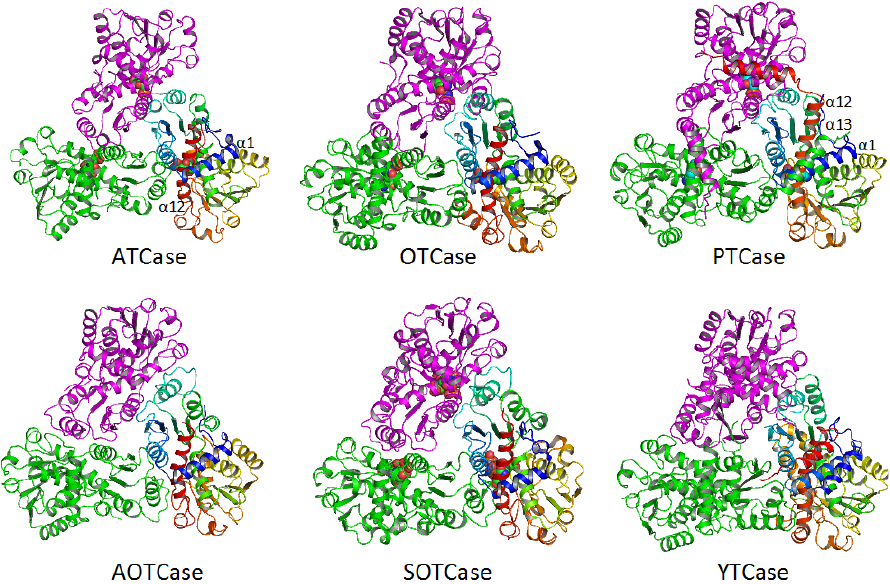
Figure 4. Ribbon diagram of the catalytic trimer of Escherichia coli ATCase, E. coli OTCase, Enterococus faecalis PTCase, Xanthomonas campestris AOTCase, Bacteroides fragilis SOTCase and E. coli YTCase, viewed down the three-fold axis. Different subunits are shown in different colors (rainbow, green and magenta,